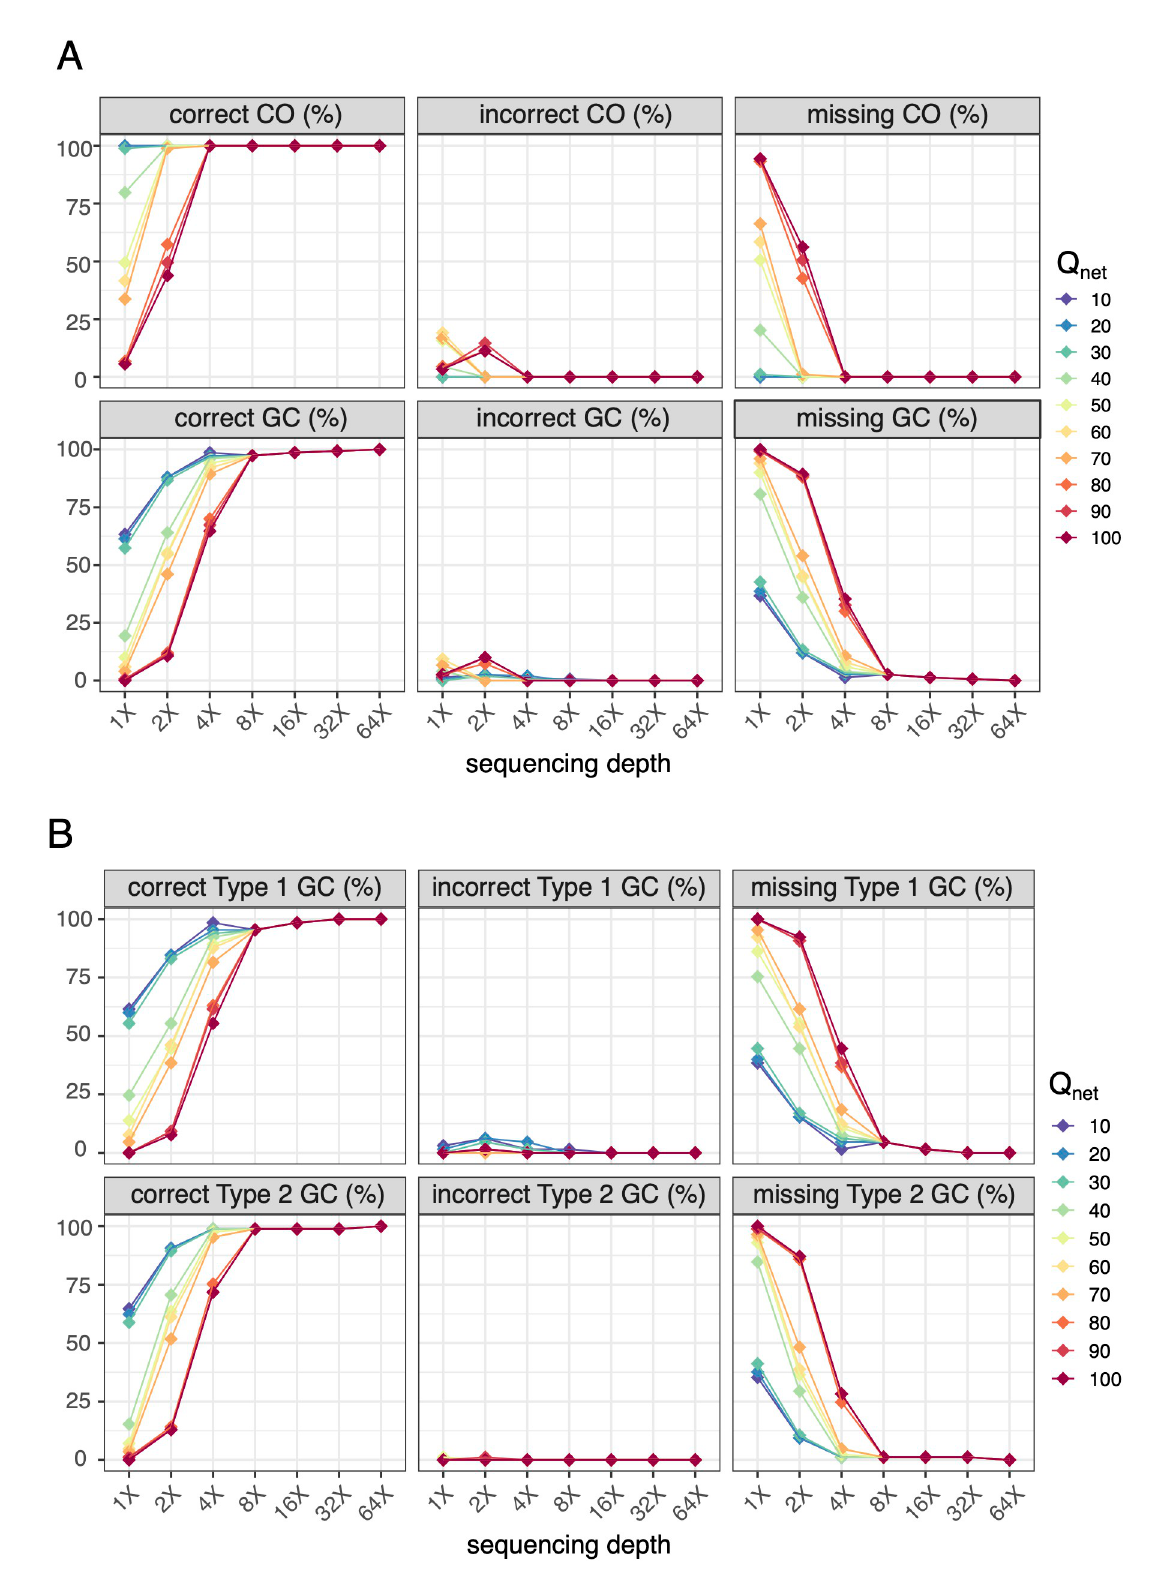
Fig 5. Performance of recombination profiling with RecombineX based on simulated data. The RecombineX-identified CO and GC events were compared with the simulated ground truth. (A) The percentage of correct, incorrect, and missing total CO and GC events identified